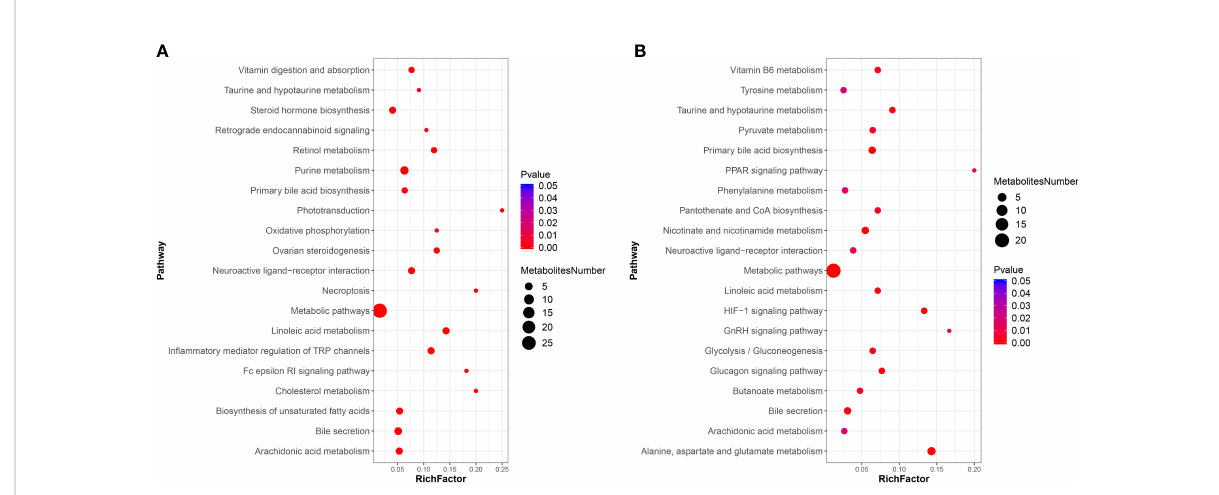
FIGURE 8 KEGG pathway enrichment analysis of DMs between the PBS-injected group and the DIV1-infected group (A) positive ion mode. (B) negative ion